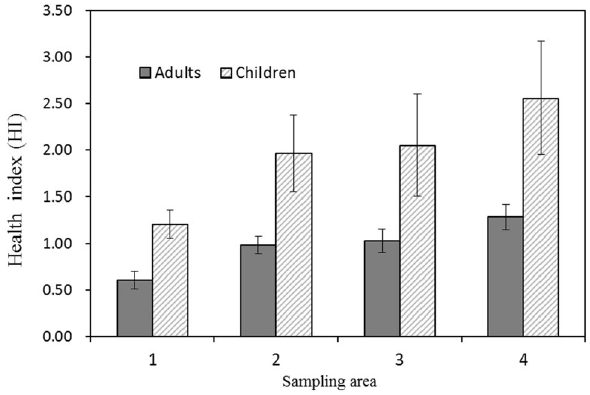
Figure 3. The health index (HI) of heavy metals for adults and children in different sampling areas (mean ± standard